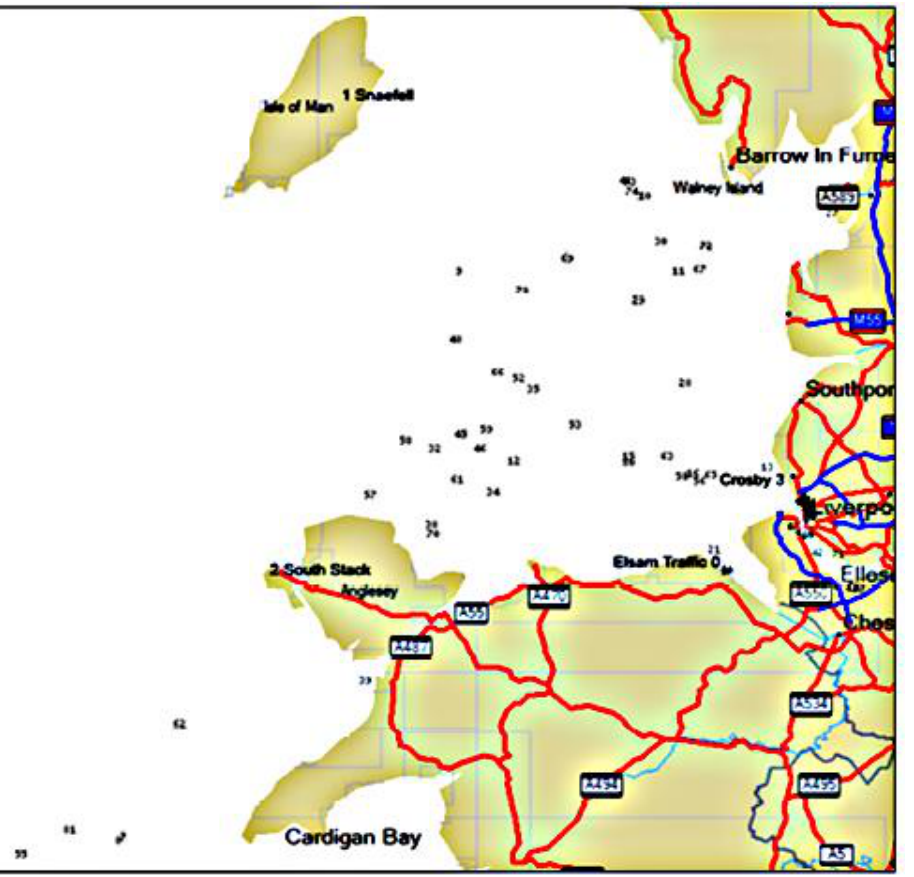
Figure 11. Location of nodes at start of a sample run including vessel traffic service (VTS). The four fixed nodes are numbered (0–3), labelled, and shown in black. The remaining nodes are shown in grey with their node numbers.